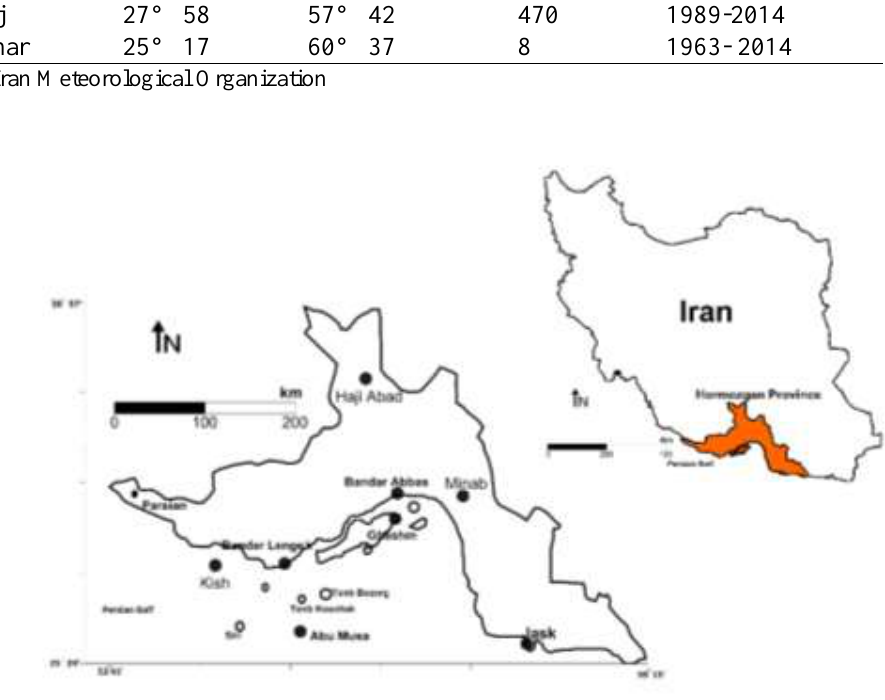
Figure1. The study